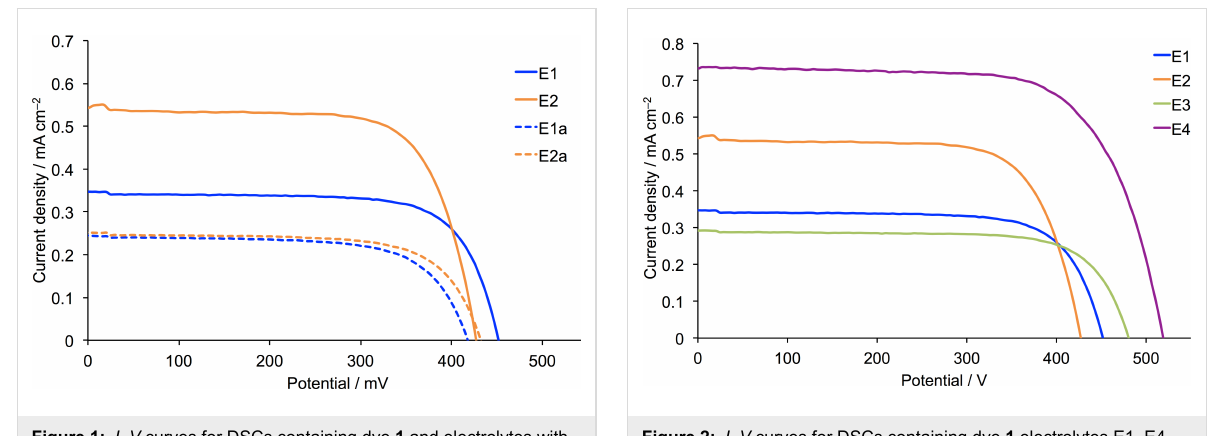
E2, Table S1 and Table S3, Supporting Information File